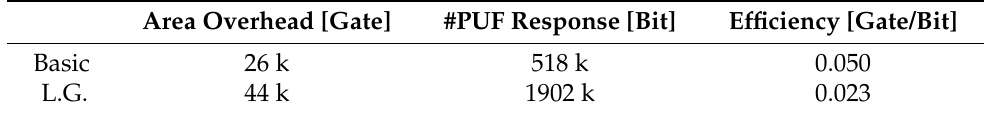
Table 2. PUF response and circuit